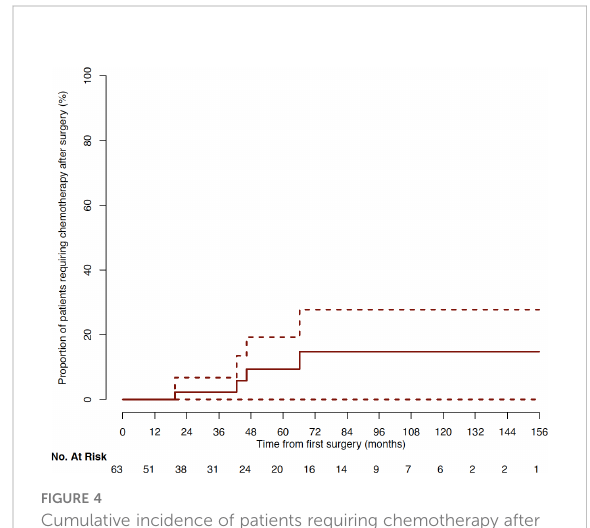
FIGURE 4 Cumulative incidence of patients requiring chemotherapy after surgery (Kaplan – Meyer representation).